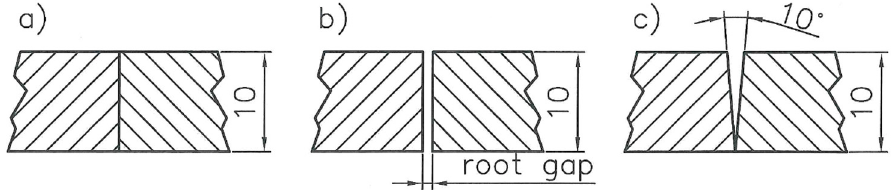
Figure 1. Butt-joint configurations used in the experiments: ( a ) Closed square (root gap = 0 mm); ( b ) open square (root gap = 0.4 mm and 0.8 mm); and ( c ) V-groove with 10-degree groove angle, closed gap and without root face. Table 1. Chemical composition of the base (AISI 316L) and filler (2205 duplex) material. Element